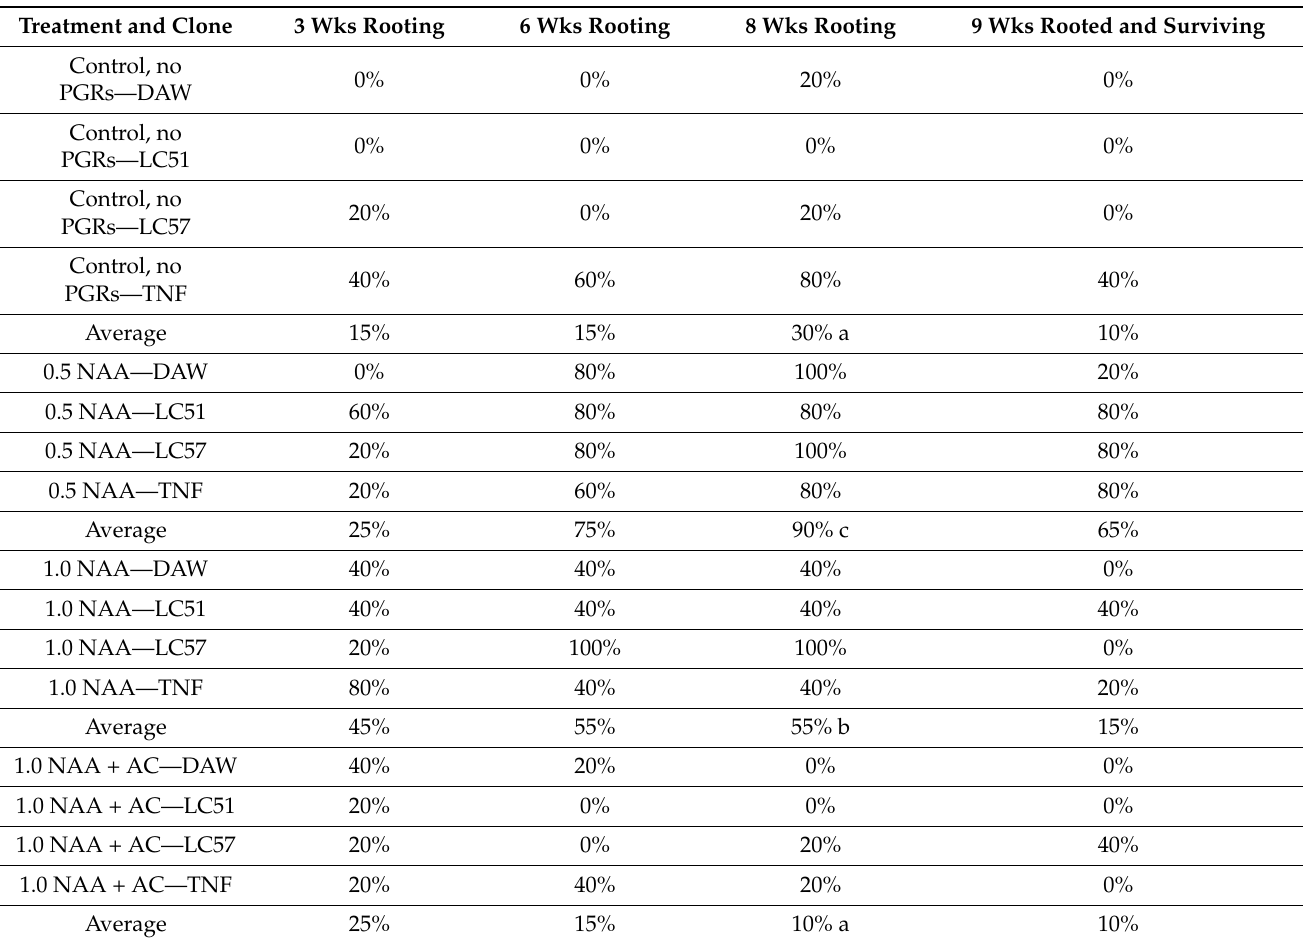
Table 6. Xerophyllum asphodeloides shoot rooting percentage after placement in in vitro rooting medium containing 1 and varying amounts of NAA and activated carbon.